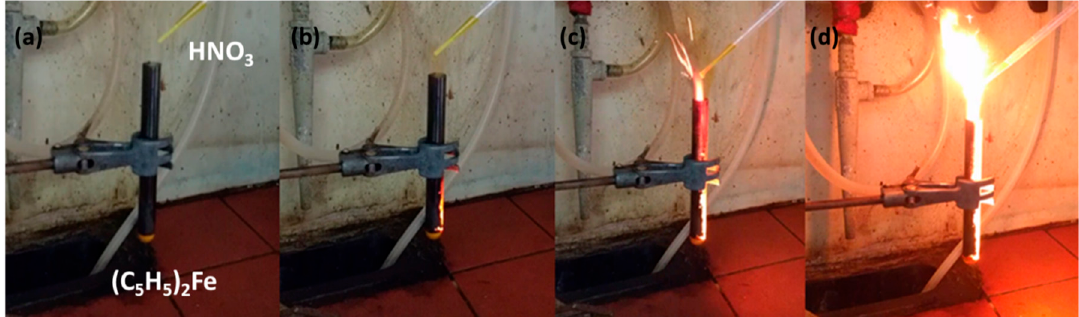
Figure 2. ( a – d ) Dropwise addition of fuming nitric acid into a test tube containing ferrocene powder resulted in the hypergolic ignition of the cyclopentadienyl compound by the acid (e.g., intense burst of flame) and the subsequent formation of γ -Fe 2 O 3 inside the tube. The magnetic solid was recovered by scratching off and washing the dark brown residue from inside the tube.